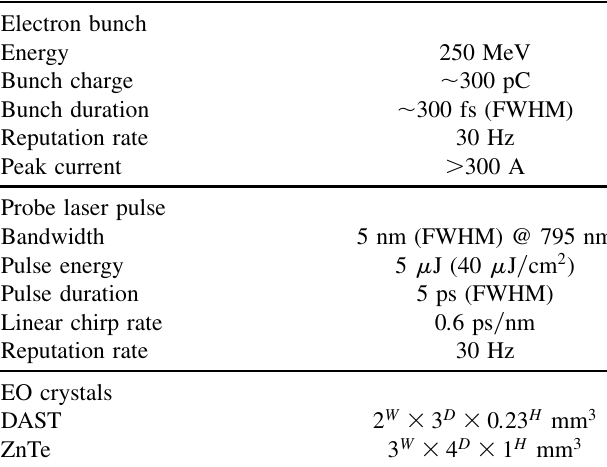
FEASIBILITY STUDY OF A SINGLE-SHOT 3D . . TABLE II. Experimental conditions at the EUV-FEL accelera- tor, SPring-8.